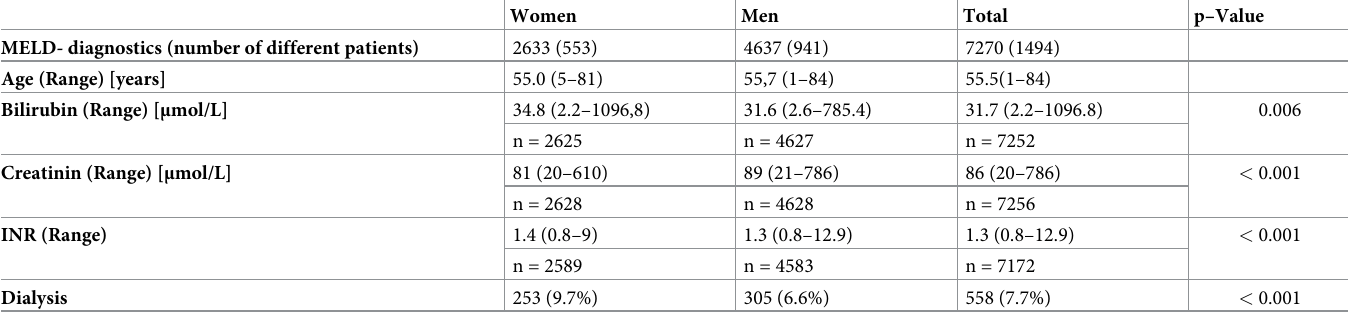
Table 1. Summary of the characteristics of cases that required MELD diagnostic from November 2012 until October 2018 within the university hospital Leipzig.